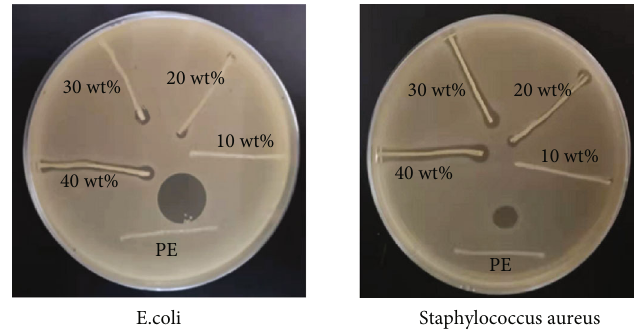
Figure 7: Pictures of the PP-g-PHMG/PE alloy mono fi lament against E. coli and Staphylococcus aureus tested with the ring di ff usion